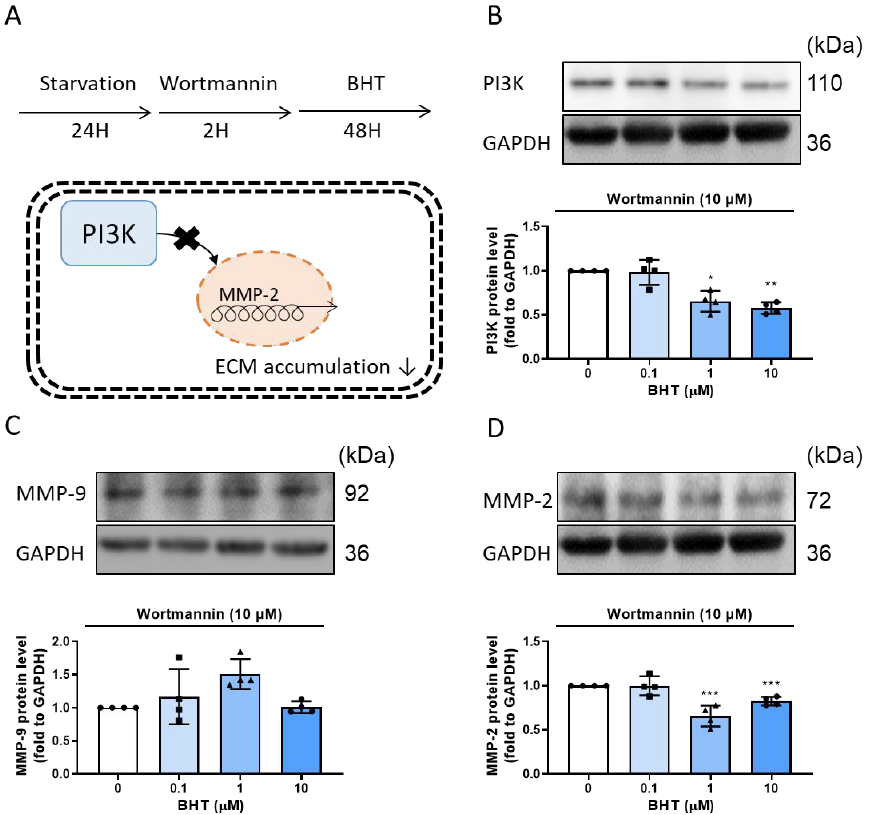
Figure 5. The potential modulative signaling pathway in BHT0induced ECM accumulation: ( A ) the flowchart shows that treated with PI3K inhibitor wortmannin for 2 h and treated with BHT for 48 h to evaluate the PI3K modulated BHT’s effect in ECM accumulation. After treatment, Western blot analysis was used to evaluate the ( B ) PI3K, ( C ) MMP-9, and ( D ) MMP-2 protein expression. *, p < 0.05; **, p < 0.01; and ***, p < 0.001 compared with the control group. GAPDH was used as loading control.